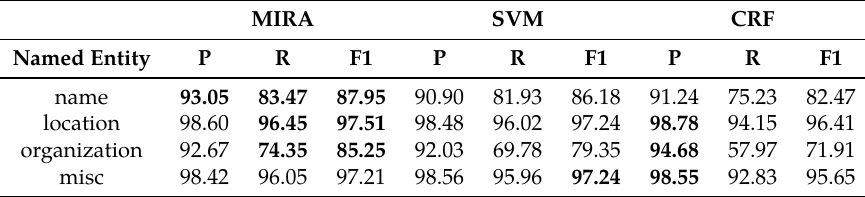
Table 9. Experimental results of each NE class on the test set using contextual, word-level, corpus, and gazetteer features.